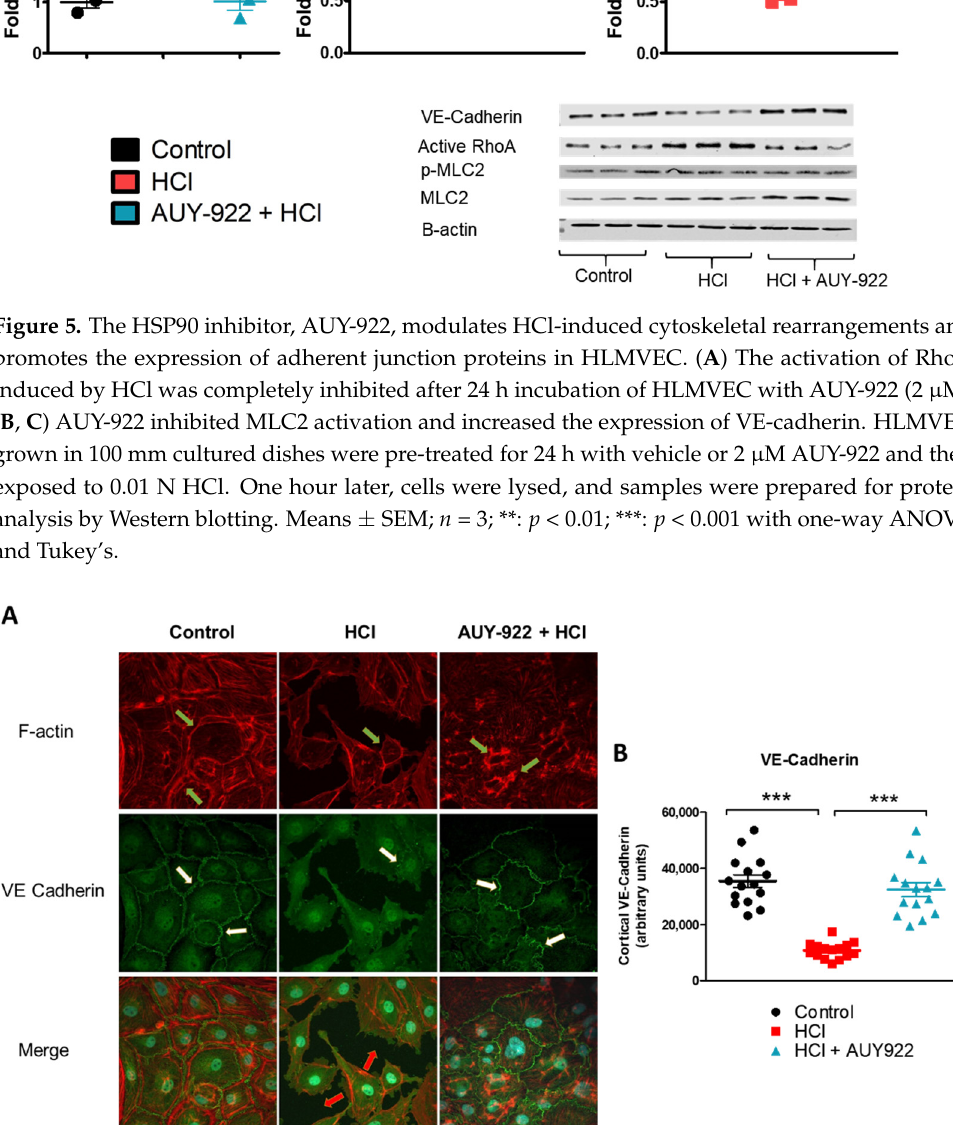
Figure 6. AUY-922 protects HLMVEC against HCl-induced VE-cadherin and F-actin reorganization. ( A ) HLMVEC were pre-treated with either vehicle (PBS) or AUY-922 (2 µM) for 24 h and then exposed to 0.01 N HCl for 1 h. Cells were fixed and stained for VE-cadherin, F-actin, and DAPI. ( B ) Quantification of cortical VE-cadherin staining. Means ± SEM; n = 3; ***: p < 0.001 with one-way ANOVA and Tukey’s.